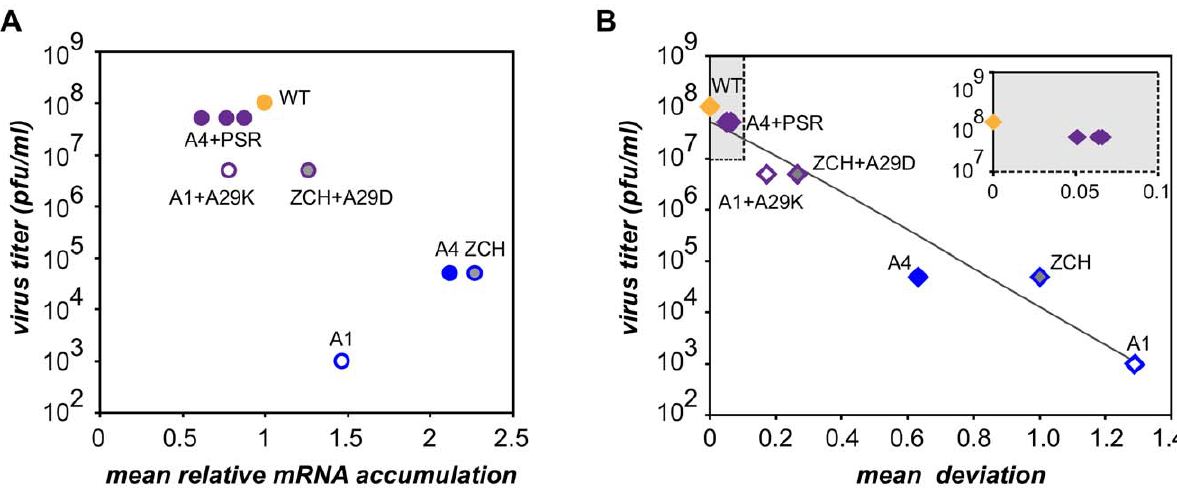
Figure 8. Relationship between viral mRNA accumulation profiles and infectious virus yield. The data obtained on the accumulation of genome and sg mRNAs were used for a quantitative assessment of nsp1 mutant phenotypes in terms of (A) changes in mRNA accumulation compared to wt and (B) the extent to which the balance between viral transcripts was disturbed (B). (A) For each mutant and pseudorevertant, a value for the accumulation of each of its 7 mRNAs at 11 h post-transfection had been assigned as compared to that of the wt control (see Fig. 4B, 7B and 7D). The mean of these seven values (‘‘mean relative mRNA accumulation’’) was plotted against the corresponding progeny virus titer in culture supernatants at 24 h post-transfection (Fig. 6B and table 2). Wild-type is depicted in orange. The engineered nsp1 mutants and nsp1 pseudorevertants are shown in blue and purple, respectively. The three pseudorevertants of mutant A4, displaying very similar phenotypes, are indicated as A4 + PSR. (B) For each mRNA species, the deviation of its relative accumulation from the mean of the complete nested set of mRNAs (see panel A) was calculated. From these seven values, the mean (absolute) deviation was calculated for each mutant and plotted against virus titers as in (A). For wt, the mean deviation is 0. Engineered nsp1 mutants and their pseudorevertants are indicated as in (A). The data fit a negative exponential regression calculated using Microsoft Excel and depicted as a gray line (y=6 6 10 6 + 7e 2 8.4306x , R 2 =0.95). The inset shows an expanded view of the upper left quadrant of the graph (shaded in